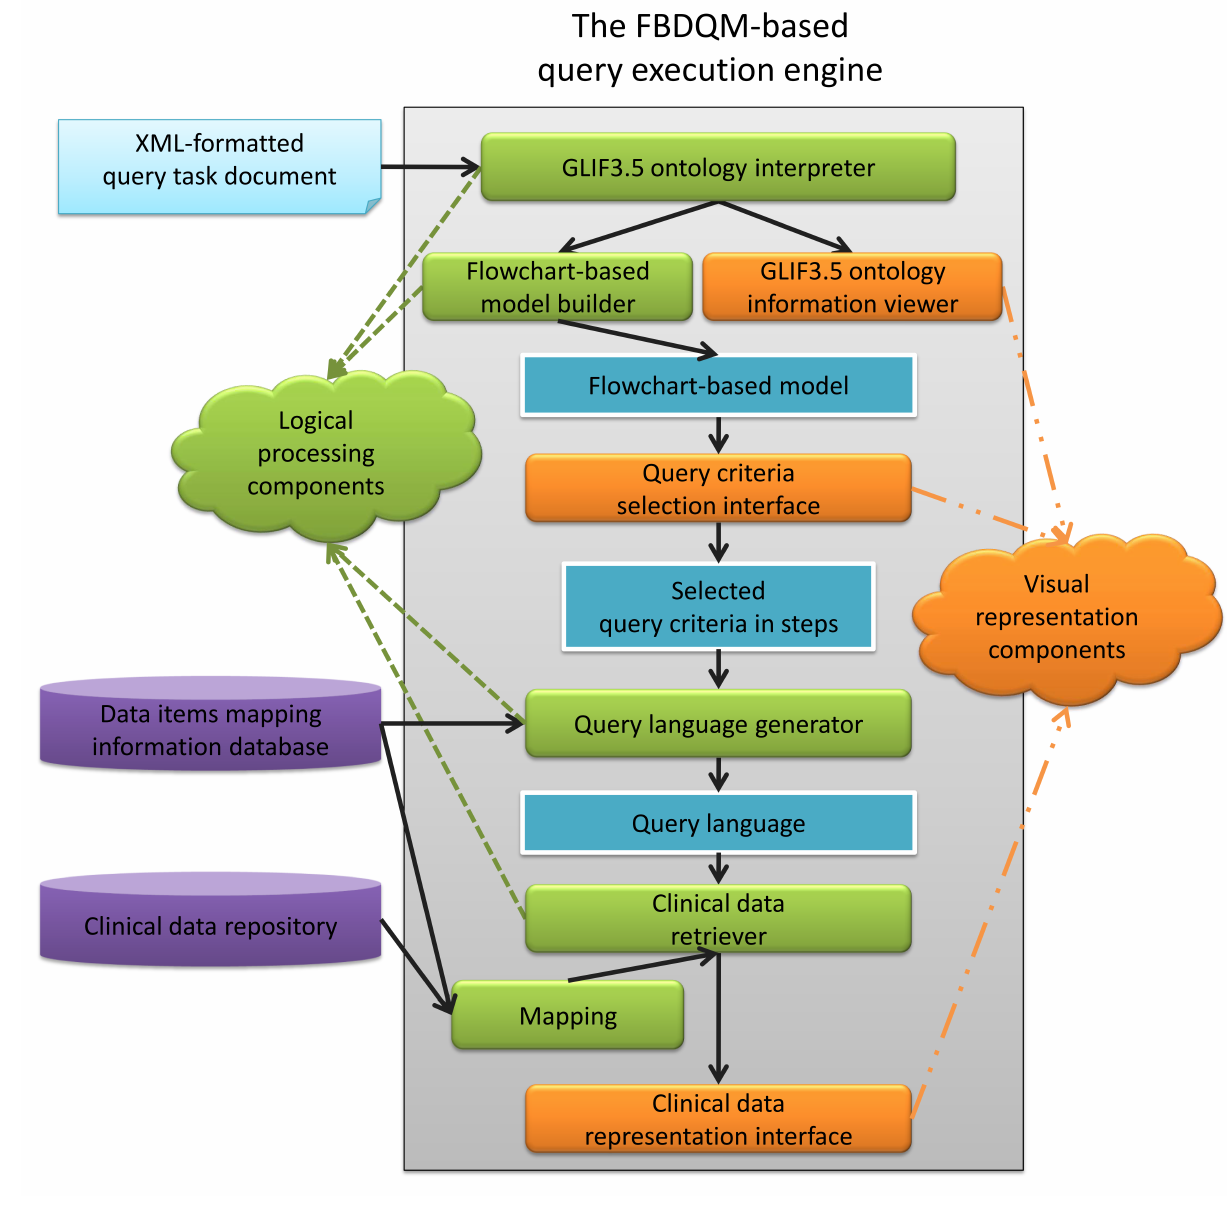
Figure 2. The architecture of the FBDQM (flowchart-based data-querying model)-based query execution